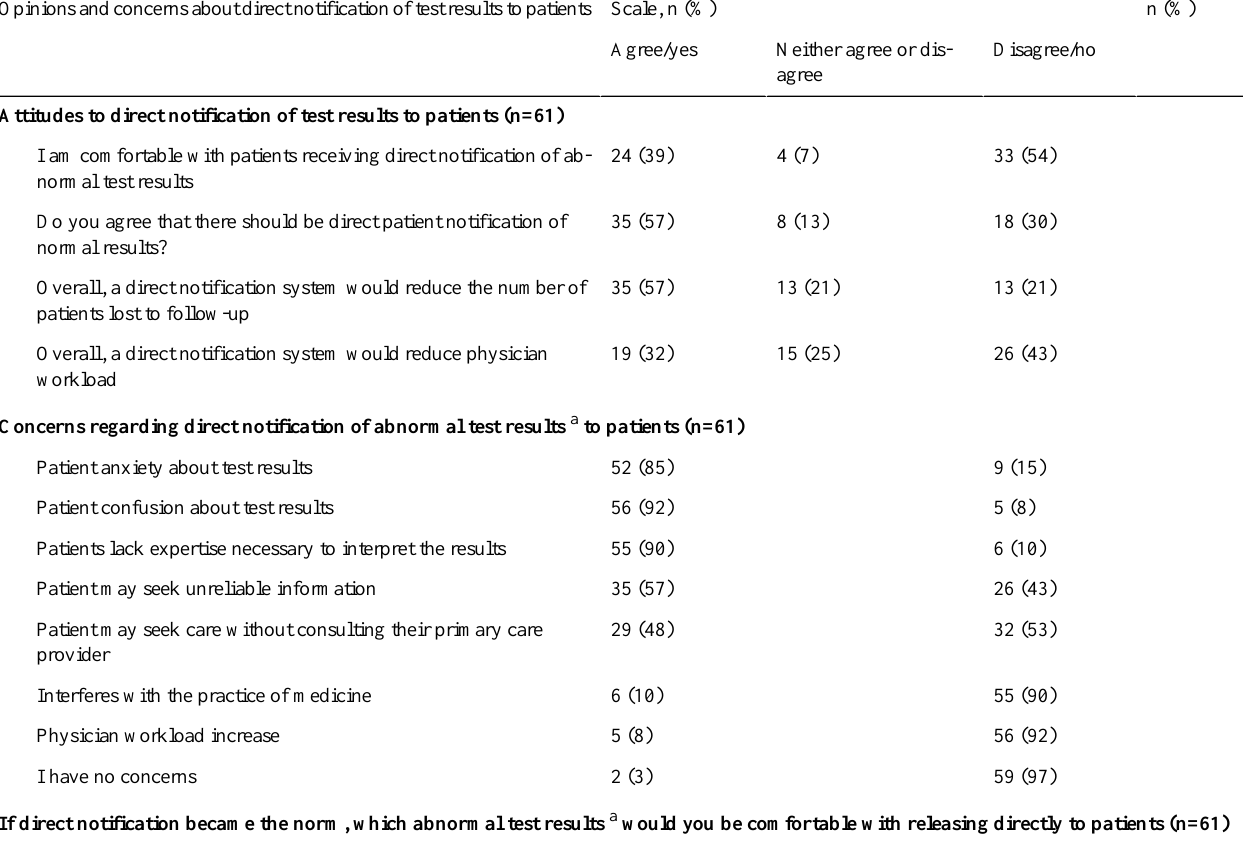
n (%)Scale, n (%)Opinions and concerns about direct notification of test results to patients